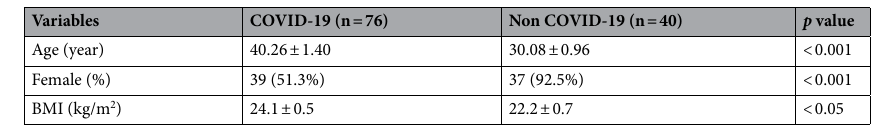
Table 1. Clinical characteristics of participants with past COVID-19 and controls (mean ± SE). Participants with recent COVID-19 were older, had higher BMI and were more likely to be female, than